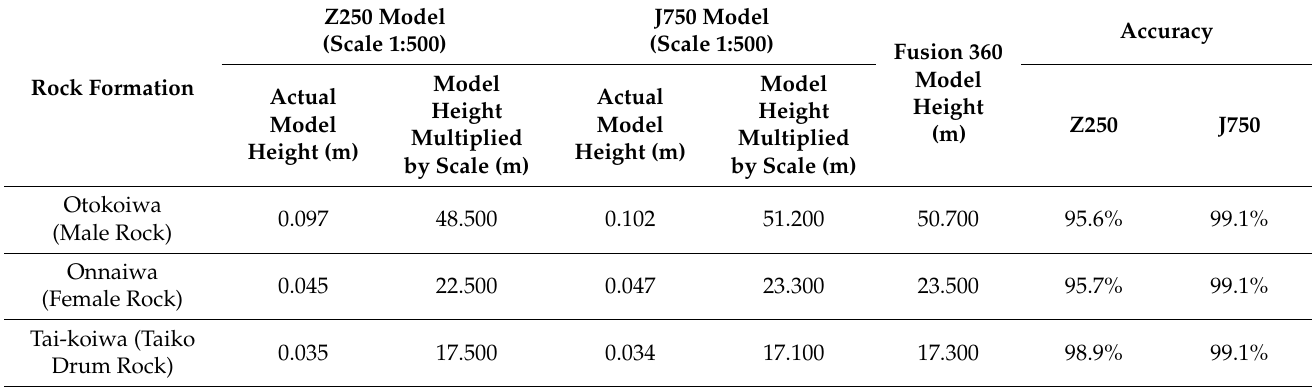
Table 3. Size comparison of 3D model